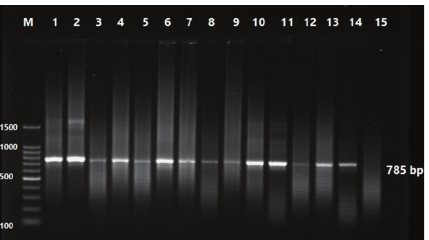
Figure 2: (Tams-1) target based PCR amplified DNA from Theileria annulata infected animals M, 100bp DNA Marker Lanes 1 :14 positive samples yielded PCR products at 785 bp, lanes 15 negative sample. Table 1: Confirmed Theileria annulata infection by the three diagnostic